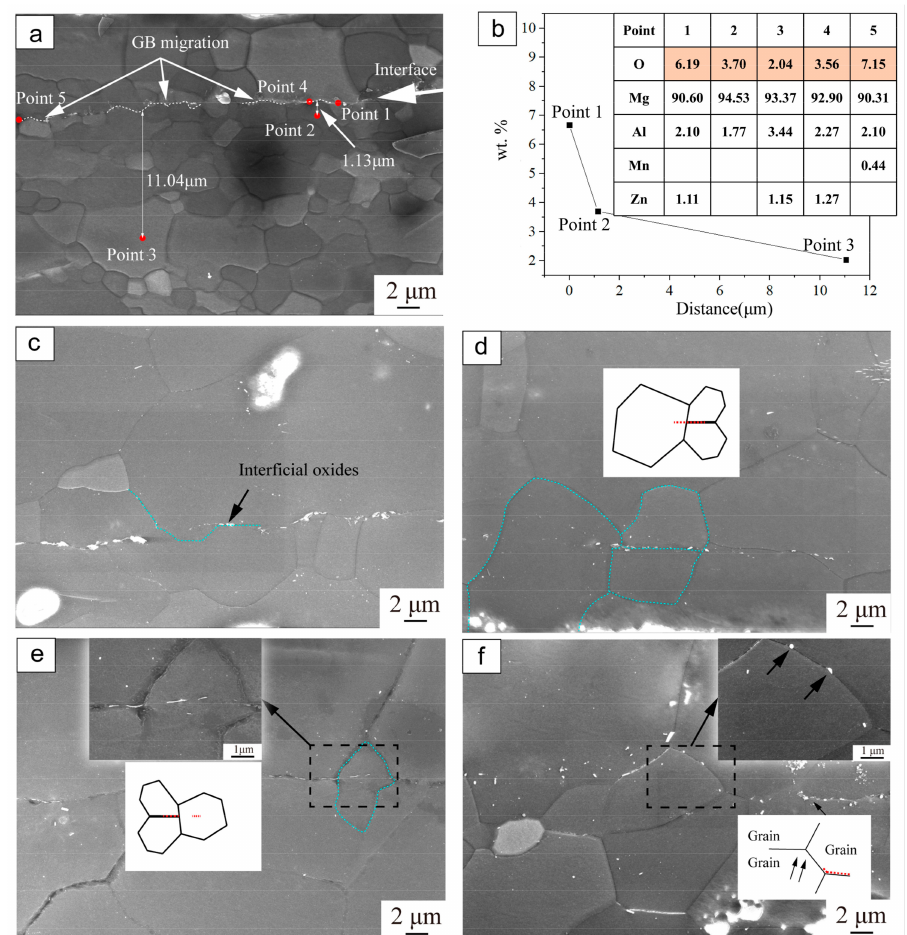
Figure 4. SEM images and EDS results of the interfacial oxides evolved with different holding times: ( a ) As-compressed under a strain of 0.6, without holding; ( b ) EDS results of elemental characterization corresponding to the points in Figure 4a; ( c – f ) Post-holding treated for 1 h, 2 h, 8 h and 12 h,